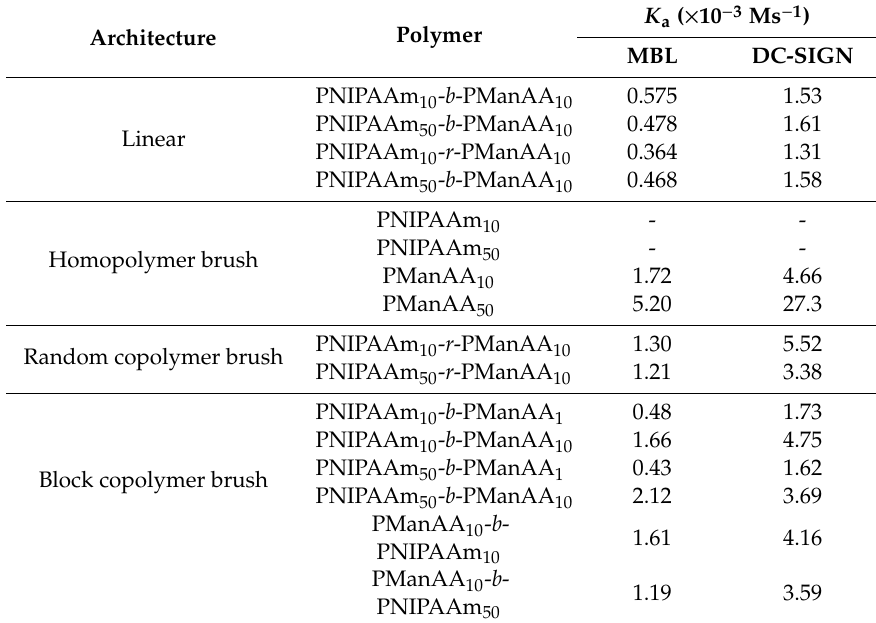
Table 1. Association constants ( K a ) between MBL and DC-SIGN lectins and PNIPAAm- and PManAA-based (co)polymers with di ff erent architecture and